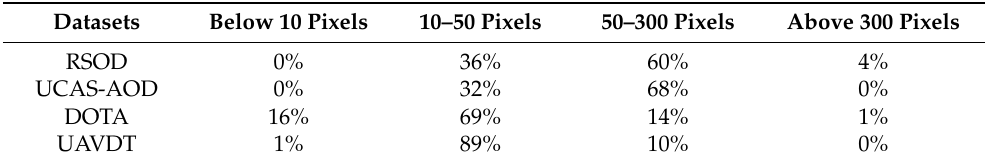
Table 1. Comparison of instance size distributions of the RSOD, UCAS-AOD, and DOTA datasets.